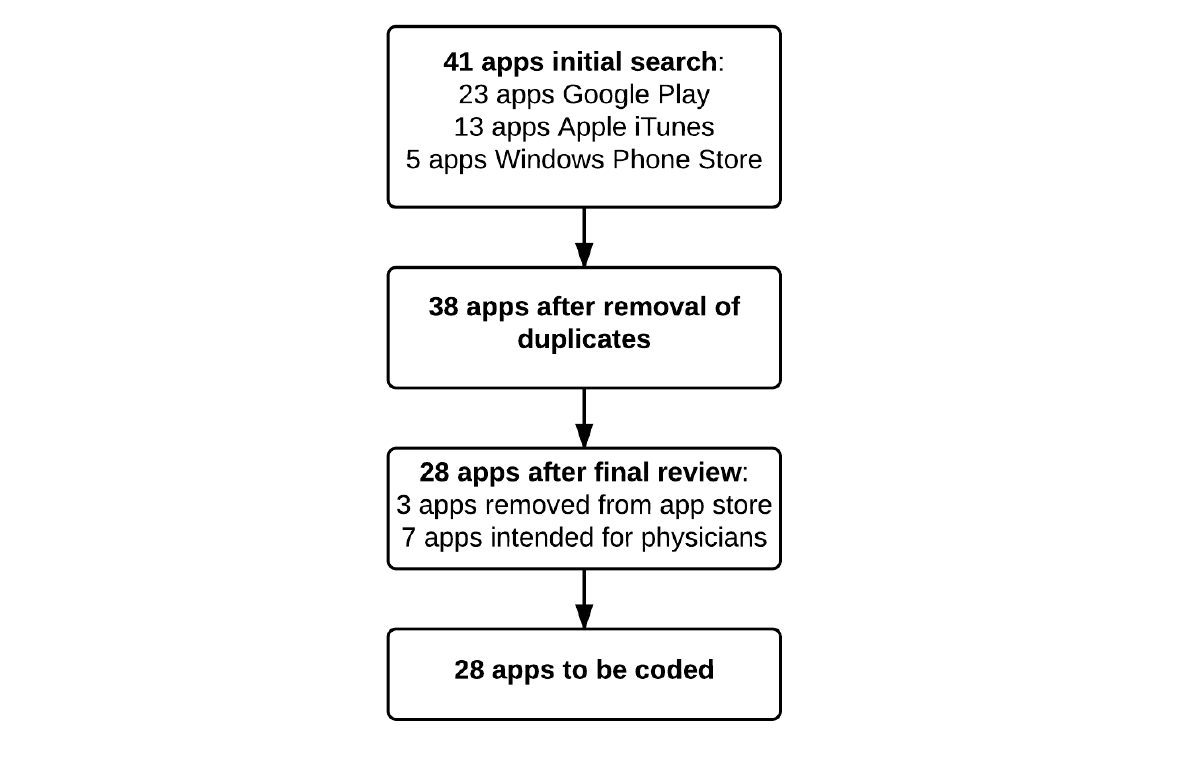
Figure 1. App selection